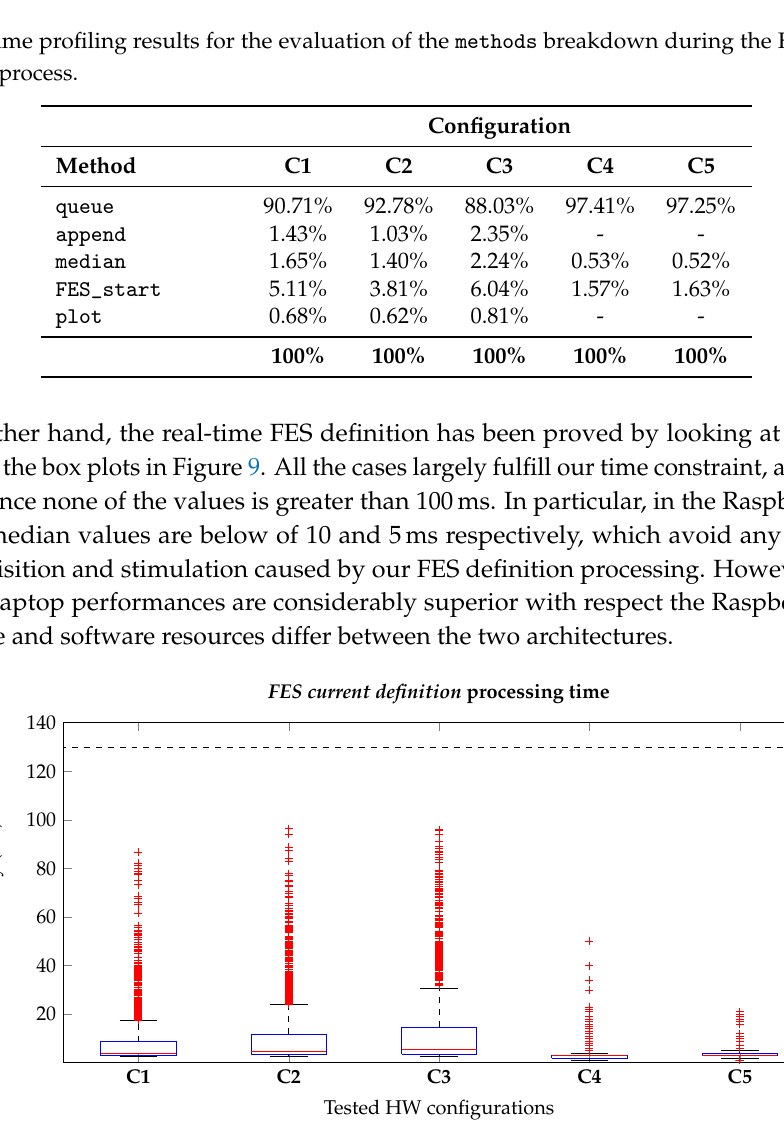
Figure 9. Box plots representing the time delays related to the FES current definition method for the different system configurations. Real-time constraints are respected, considering our time limitation of 130ms (dashed black line), both in GNU/Linux Raspberry ( C1 , C2 and C3 ) and Microsoft ® Windows ® PC ( C4 and C5 )